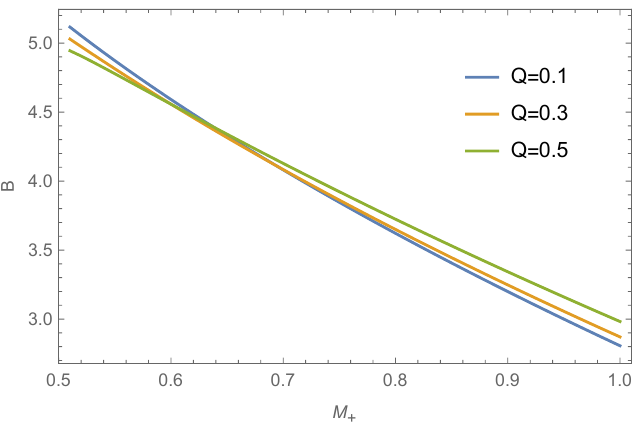
Figure 6 . The tunneling coefficient B is plotted as the function of the initial black hole mass M + . In this plot, G = 1 , L + = 1 . 335 , L − = 1 , σ = 1 , Q = 0 . 3 , and M − = 0 . 5 . The critical mass of 16 πG the initial black hole is M c = 1 . 0155